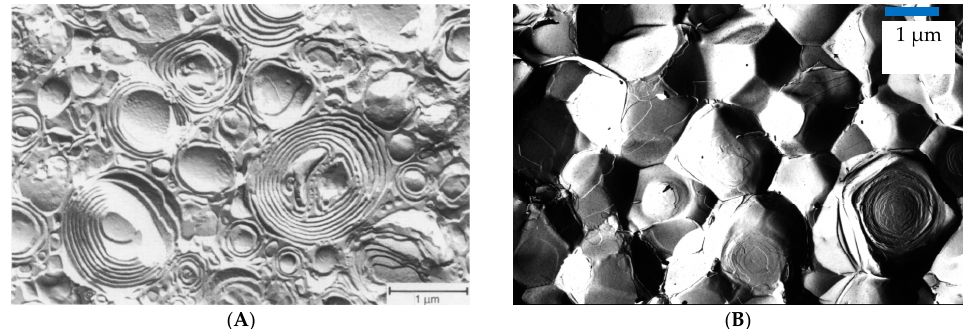
Figure 4. FF-TEM micrographs of the systems: ( A ) 90 mM TDMAO/10 mM TTABr/220 mM 1-hexanol (Reproduced (“Adapted” or “in part”) from [49] with permission of The Royal Society of Chemistry.); ( B ) 360 mM TDMAO/40 mM TTABr/780 mM 1-hexanol/700 mM NaCl.